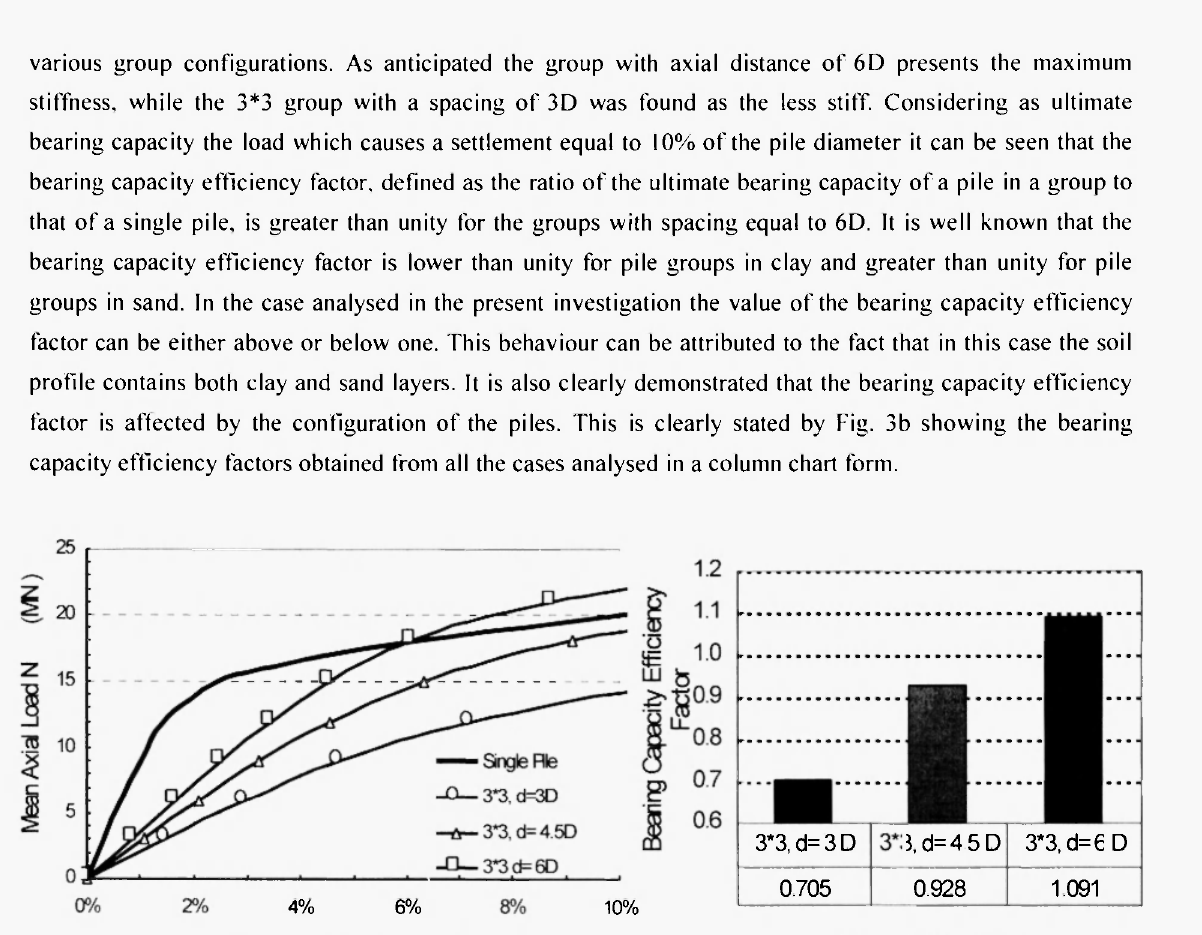
Fig. 3: a: Numerically established load-settlement curves for the single pile and a 3*3 group layout with axial distance of 3, 4.5 an 6 pile diameters, b: Bearing capacity efficiency